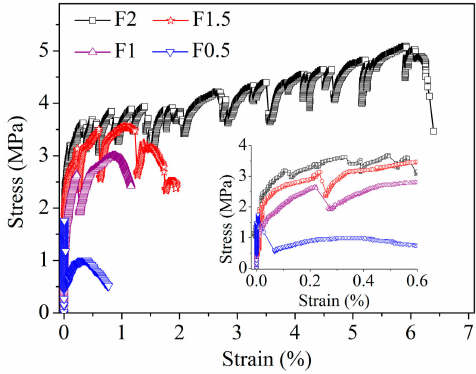
Figure 9. Stress–strain curves under uniaxial tension.